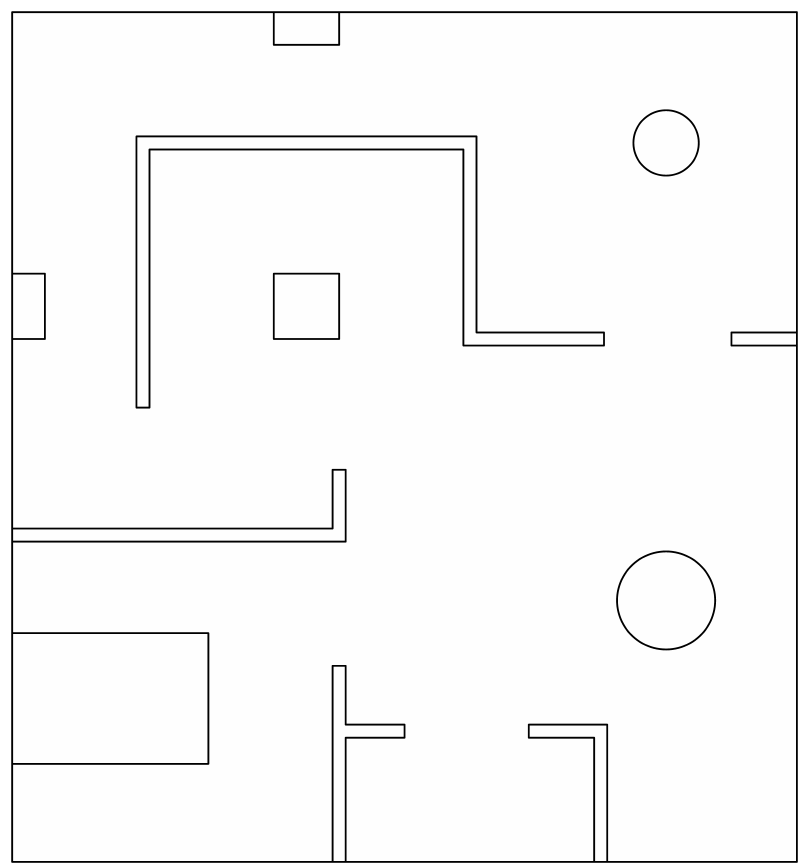
Figure 1. Common environments